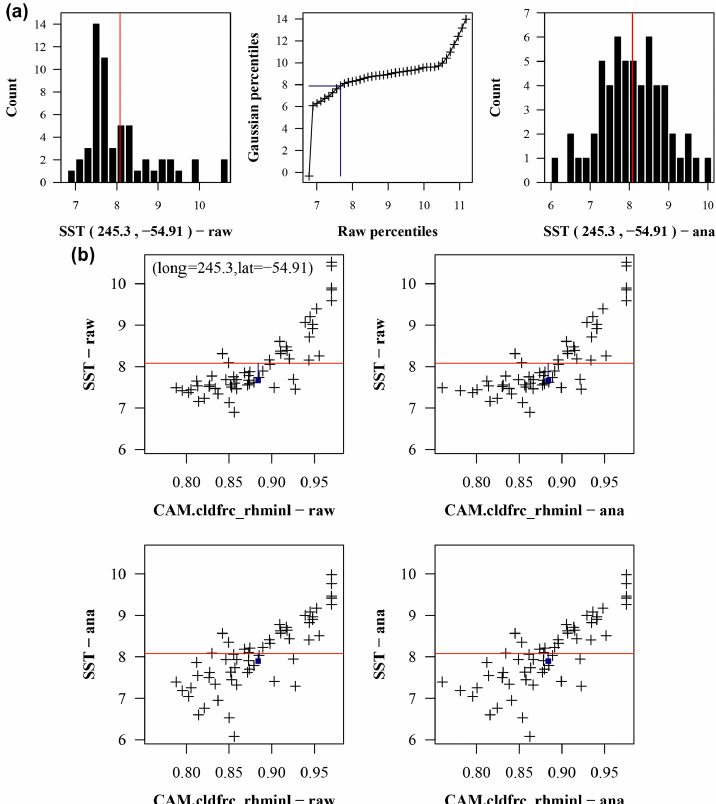
Figure B1. CESM experiment. Example of Gaussian anamorphosis transformation in a control variable (minimum relative humidity for high stable cloud formation) and the sea surface temperature (SST) for both the model equivalent of the observations and the observation (transformation details in text) at a location (245.3 ◦ E, 54.91 ◦ S) in the South Pacific (location shown in 5). Further description of symbols is as in Fig.